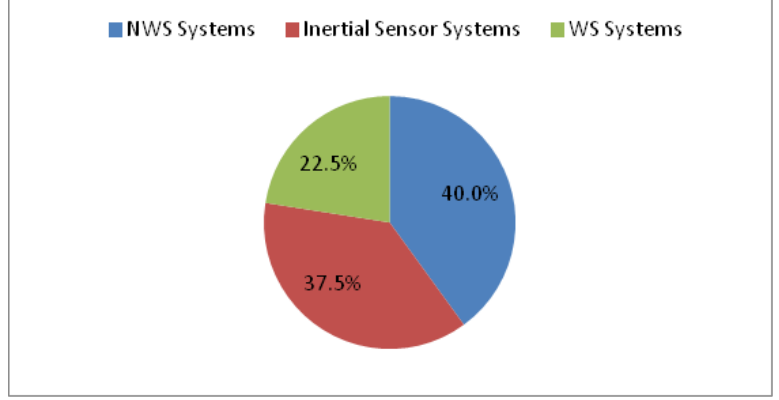
Figure 14. Classification of the reviewed papers published in 2012 and